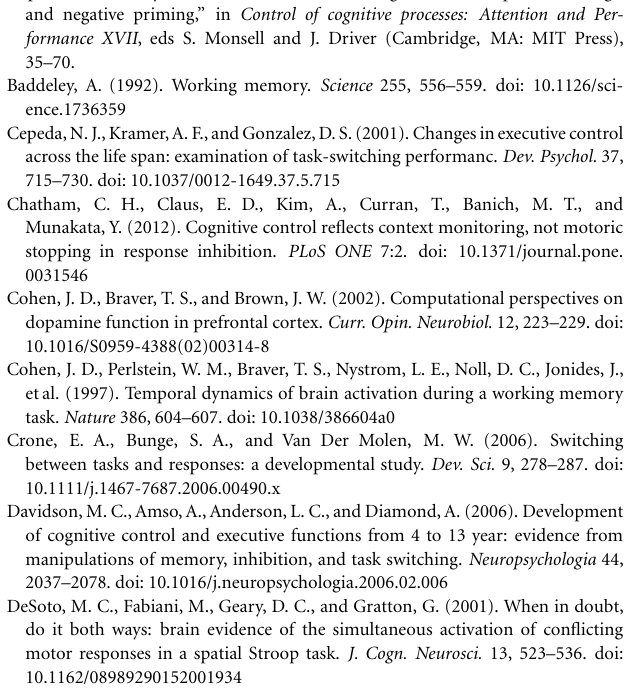
FIGURE 6 | (A) Ninety-five percent confidence interval around the mean accuracy for the congruent block in the congruent-first condition (unfilled boxes and solid lines) and comparison to the incongruent-first condition (solid box), plus or minus 2%. (B) Ninety-five percent confidence interval around the mean accuracy for the incongruent block in the congruent-first condition (unfilled boxes and solid lines) and comparison to the incongruent- first condition (solid box), plus or minus 2%. (C) Ninety-five percent confidence interval around the mean difference in accuracy between congruent and incongruent blocks in congruent-first and incongruent-first conditions. Solid lines represent the accuracy difference in the congruent- first condition and the gray box represents the accuracy difference in the incongruent-first